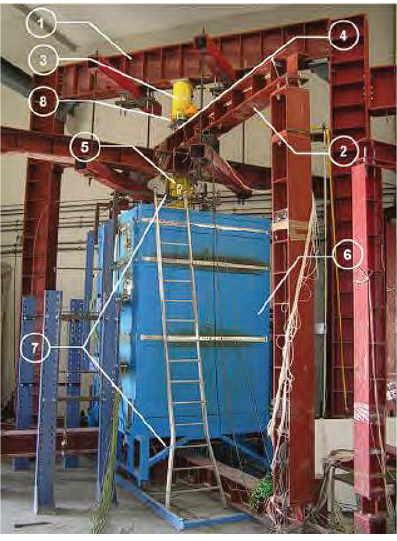
Figure 21. The fire ‐ resistance ‐ test setup on columns. Figure 21. The fire-resistance-test setup on columns.